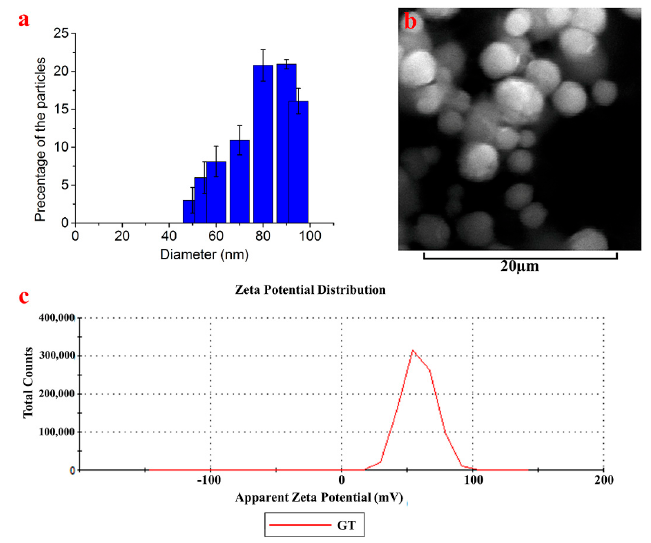
Figure 2. ( a ) Zeta size of the TGQD. ( b ) SEM analysis of TGQD with 20 µm scale bar;.( c ) Zeta potential of TGQDs. Data represent the mean ± SD, n = 5. Nanomaterials 2020 , 10 , x FOR PEER REVIEW